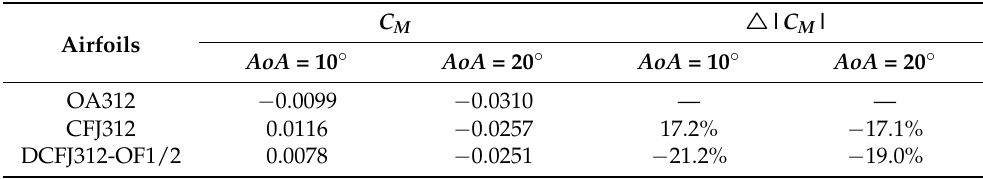
Table 6. Comparisons of moment coefficients of DCFJ312 and CFJ312 airfoils at typical AoAs.